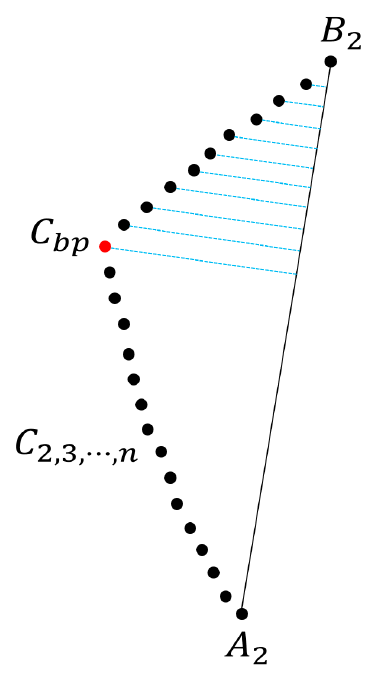
Figure 3. Center point of basilar artery with greatest bending degree calculated based on normal line.